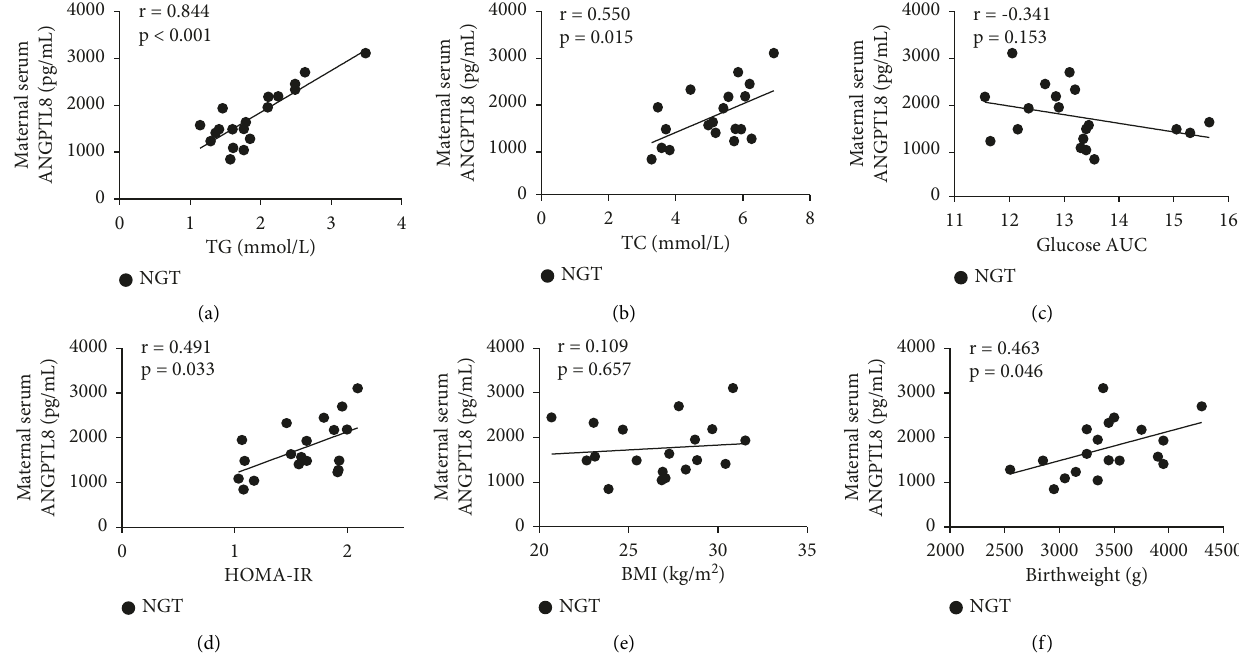
Figure 2: Correlation analysis between maternal serum ANGPTL8 and metabolic parameters of pregnant subjects with normal glucose tolerance. (a) Correlation between ANGPTL8 and TG levels. (b) Correlation between ANGPTL8 and TC levels. (c) Correlation between ANGPTL8 and AUC for OGTT. (d) Correlation between ANGPTL8 and HOMA-IR. (e) Correlation between ANGPTL8 and BMI. (f) Correlation between ANGPTL8 and